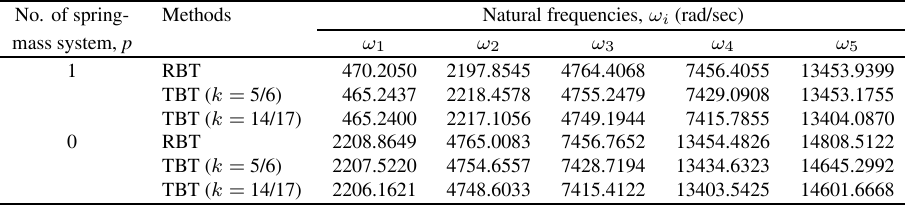
Table 3 The fi rst fi ve natural frequencies of the uniform two-span Reddy-Bickford and Timoshenko beams